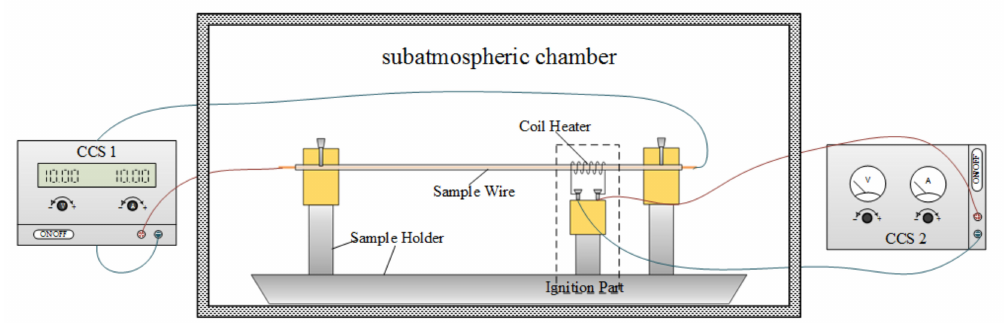
Figure 1. Schematic of the experimental